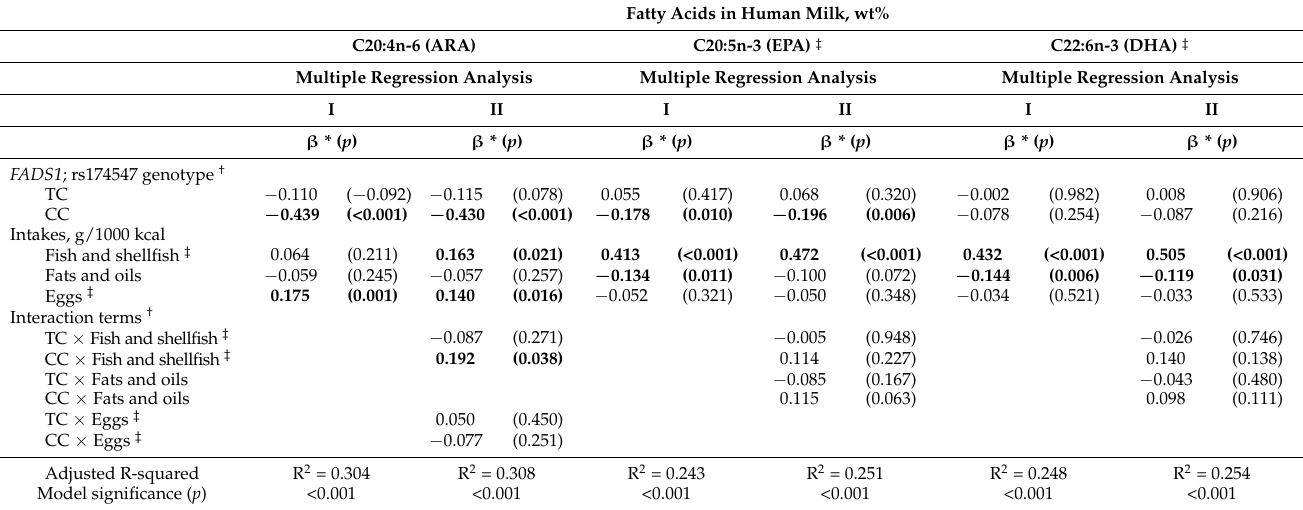
Table 4. The results of multiple regression analysis with LCPUFA compositions in human milk as the objective variable, and FADS1 rs174547 genotypes and fish and shellfish, fats and oils, and egg intakes as explanatory